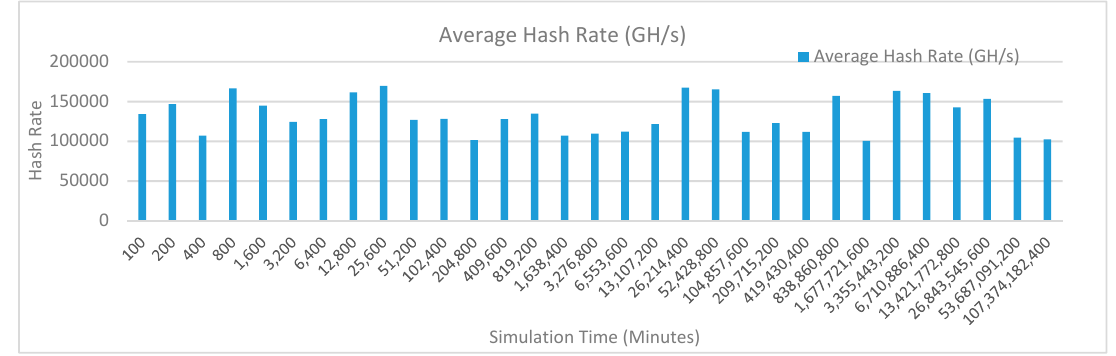
Figure 22. Average hash rate analysis (with IoT, edge, fog).